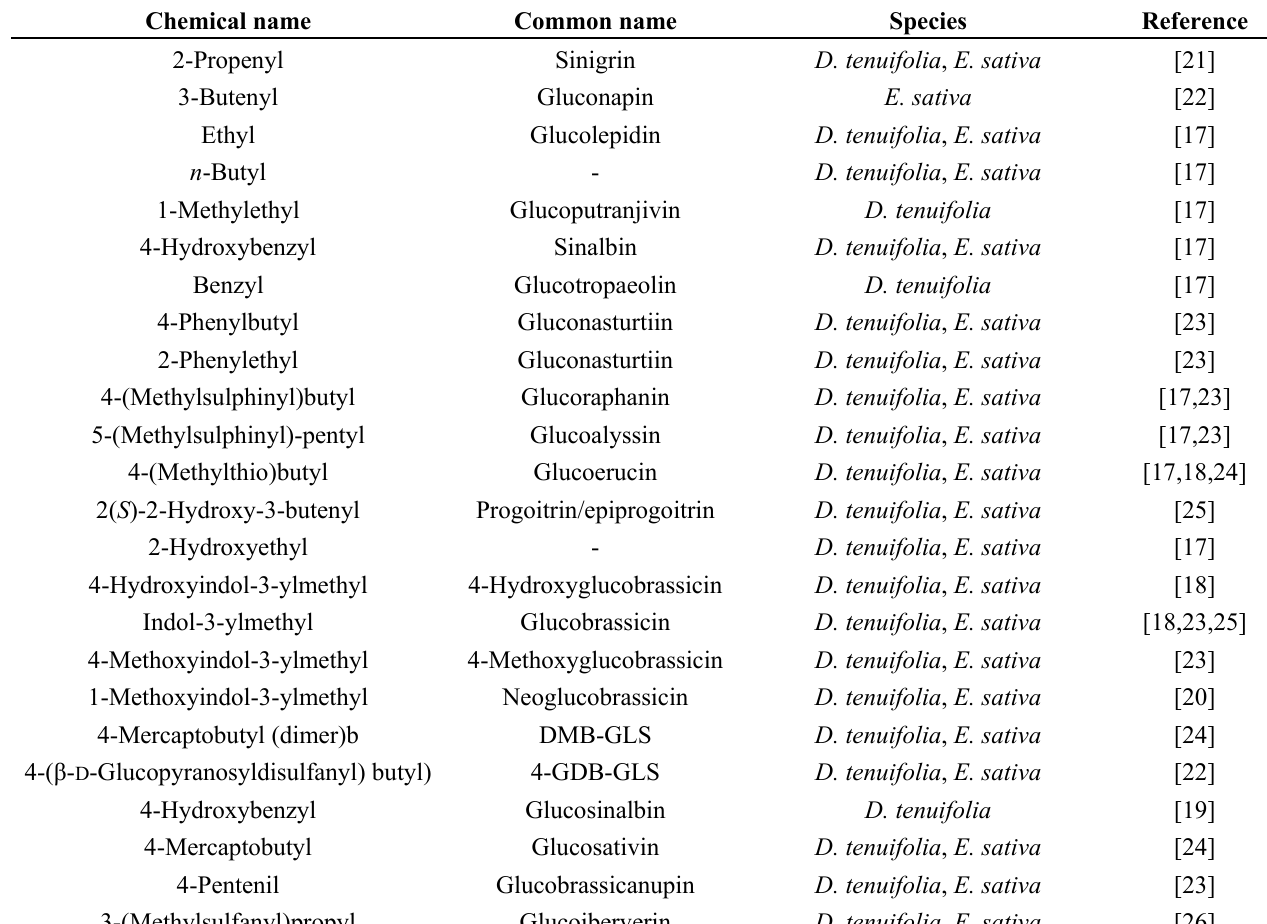
Table 1. List of the glucosinolates found in the two main rocket